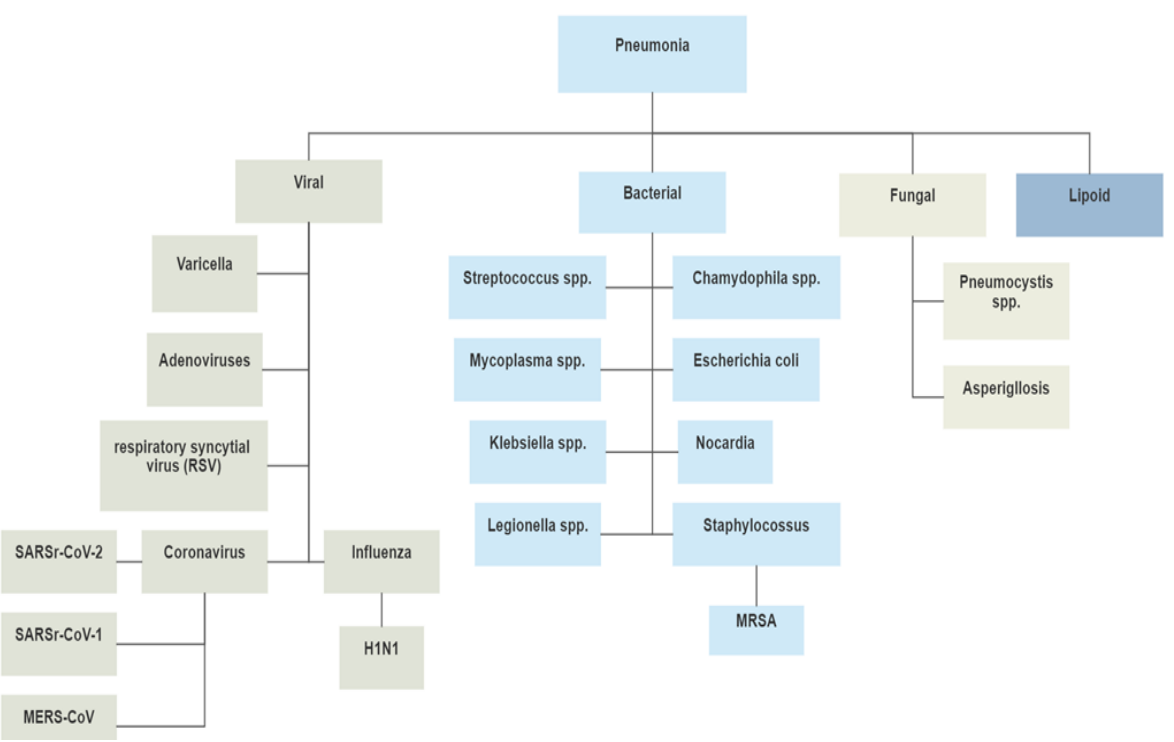
Figure 2 [17]. In the 10th revision of the ICD (ICD-10), a new type of viral pneumonia was introduced, belonging to the coronavirus family: the 2019 novel coronavirus, coded as “COVID-19”. In December 2019, COVID-19 originated in Wuhan (Hubei Province, China), after which it rapidly spread worldwide. Due to the high mortality rate of the disease and its global transmission, the WHO defined COVID-19 as a pandemic soon after.